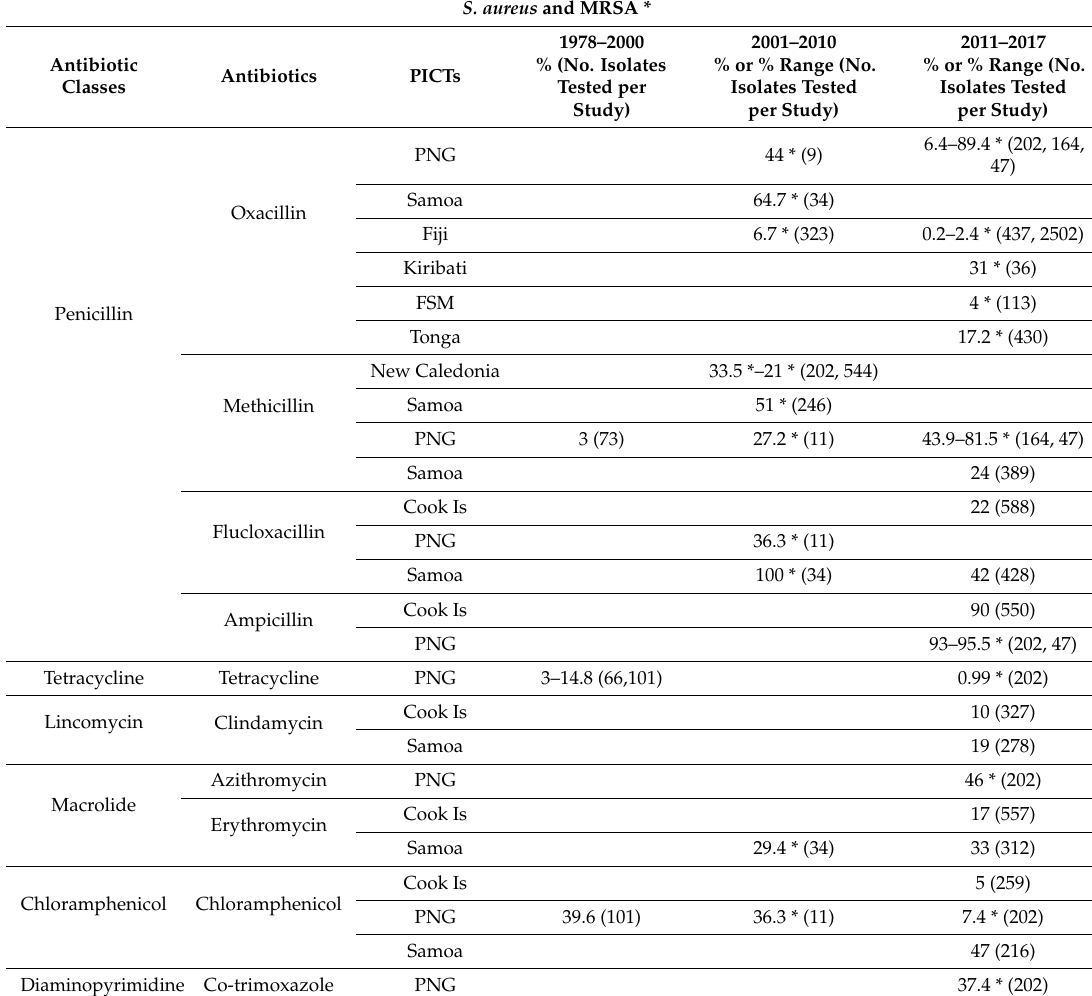
Table 4. Prevalence of Staphylococcus aureus and MRSA * reported in the PICTs by country and date. S. aureus and MRSA